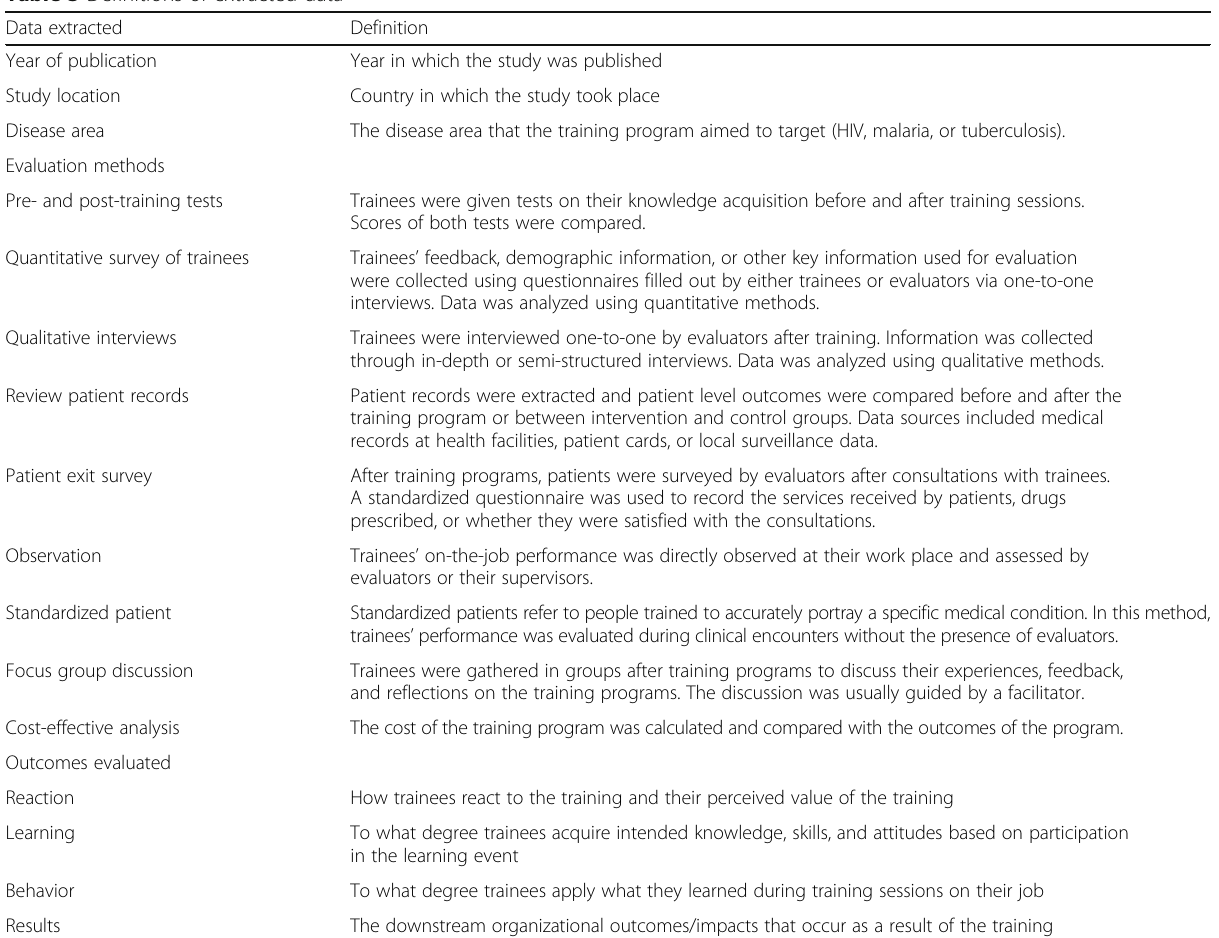
Table 3 Definitions of extracted data Data